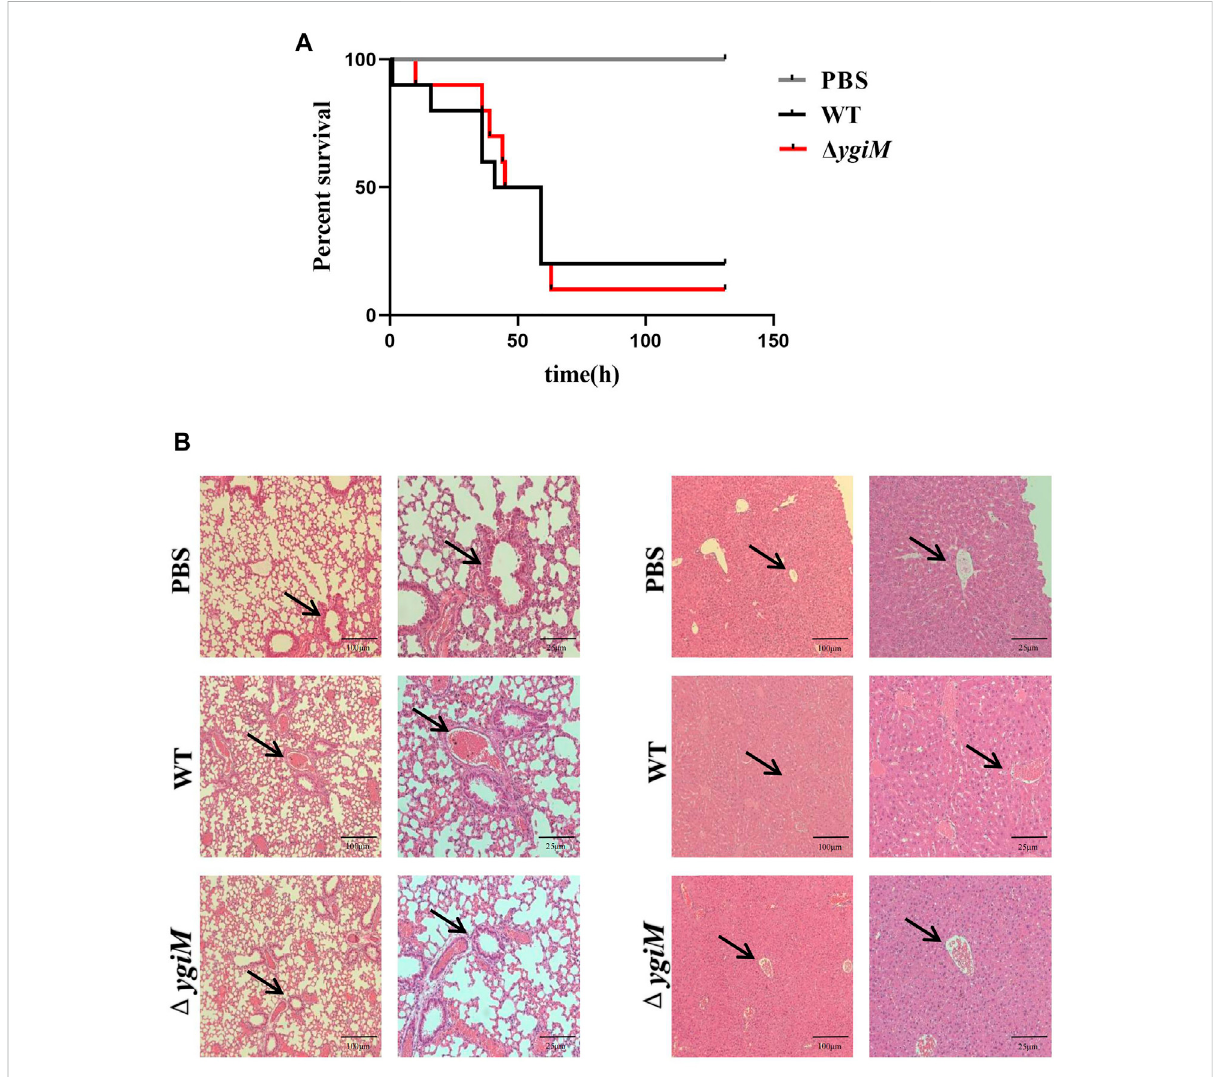
FIGURE 4 Survival curves and pathological morphology ofmice. (A) Survival curves ofmice inthe tail vein infection model. Ten mice each of PBS, WT and Δ ygiM were injected with 10 6 CFU through the tail vein, respectively. The 5 days survival rate of mice was determined. (B) Histopathology of mouse lung and liver after infection with PBS (negative control), WT and Δ ygiM . 48 h after infection, the lungs and livers of different groups of mice were dissected and stained. These numbers represent at least three sections from three mice that exhibited similar pathology in their tissues. The arrows indicate the obvious pathological